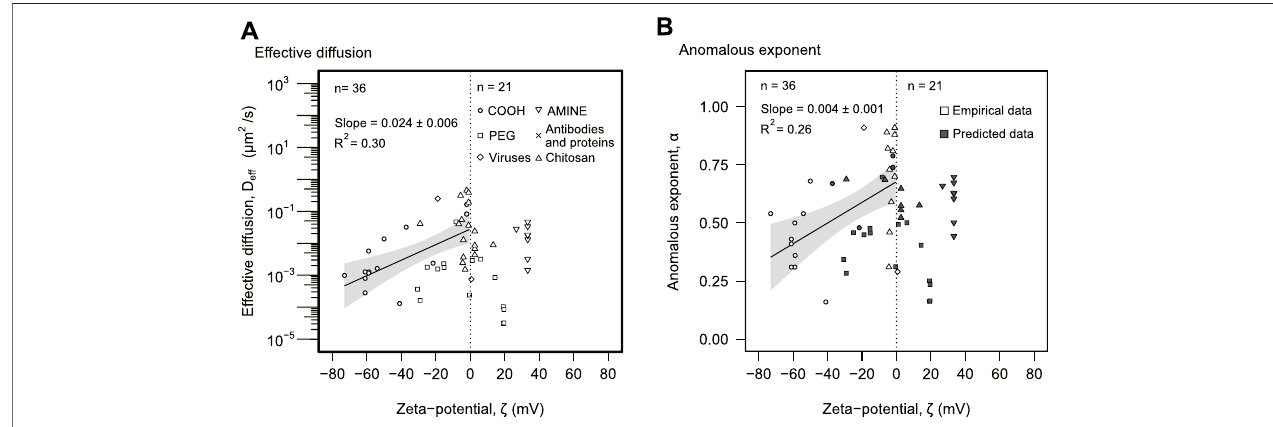
FIGURE 4 | Electrostatic analysis. (A) The effective diffusion was plotted against zeta potential. (B) The anomalous exponent was plotted as a function of zeta potential. (A,B) The distinctionbetween empirical and predicteddata aswell asparticle types isrepresentedin the legend. Thedotted lineindicates ζ (cid:1) 0. The solidlines correspond to statistically signi fi cant linear regressions. The gray areas represent 95 % con fi dence intervals of the linear regression. The slopes and R 2 of each linear regression are also displayed in the panels.